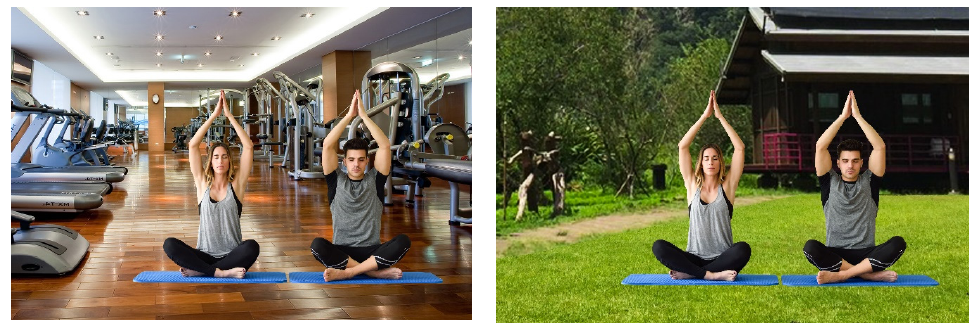
Figure 1. Two samples of the experimental pictures (portraits adopted from https://www.freepik.com/free-photo/health-beautiful-female-body-peace_1057237.htm#page=8&query=gym%20background&position=8, accessed date 1 December 2021).